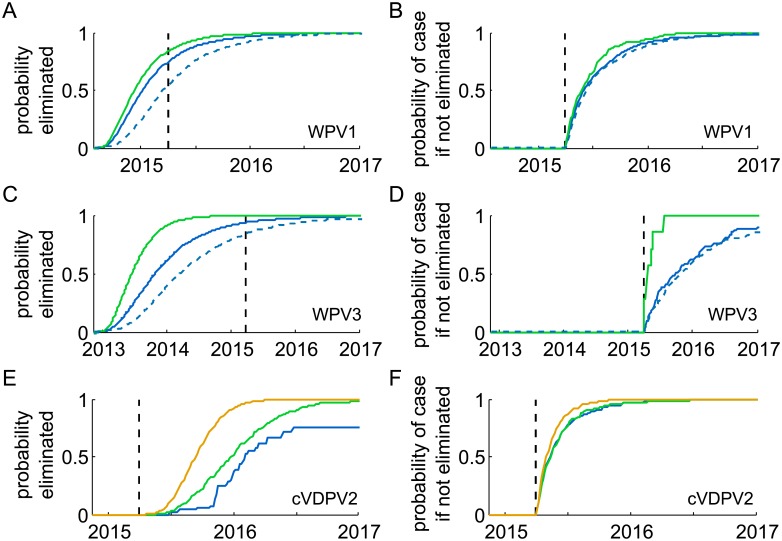
Model results for elimation and time to next case.Probability of elimination assuming no new cases are observed: WPV1 (A), WPV3 (C), cVDPV2 (E). Probability of observing a new case if elimination doesn’t occur, WPV1 (B), WPV3 (D), cVDPV2 (F). Fig prepared March 31, 2015 (black dashed line). In each panel, the horizontal axis origin is the time of the most recent case, the solid blue curve shows the scenario with mean R
eff = 1 and perfect surveillance, the green curve shows a less conservative scenario with mean R
eff < 1 and perfect surveillance, and the dashed blue curve shows a conservative scenario with mean R
eff = 1 and 50% surveillance sensitivity. For cVDPV2 (C,F), the orange curve depicts an optimistic scenario in which the mean R
eff is held at the lowest value ever observed and the standard deviation is reduced to one-fourth of its observed value.